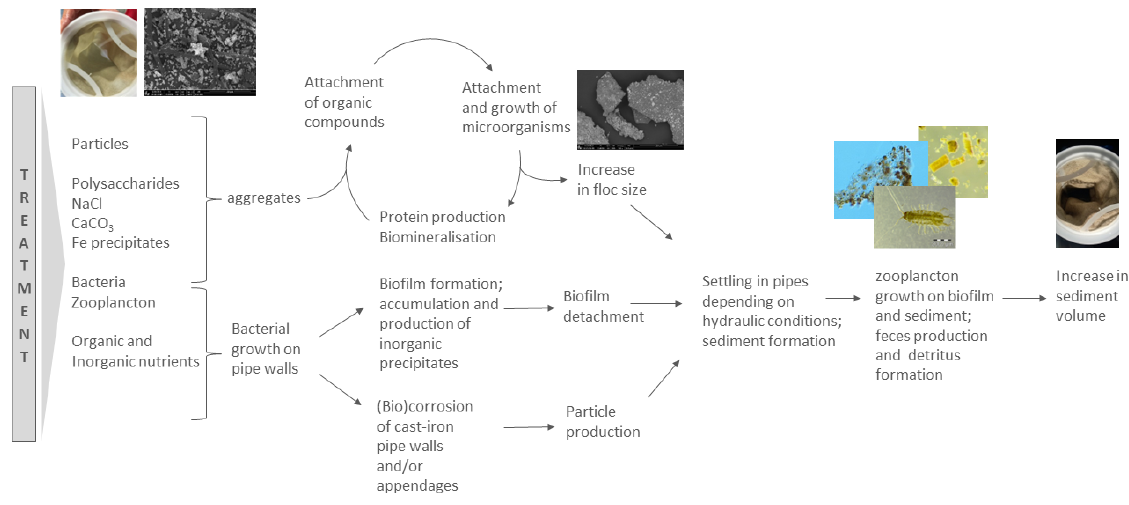
Figure 10. Hypothesis of the sediment formation mechanism .